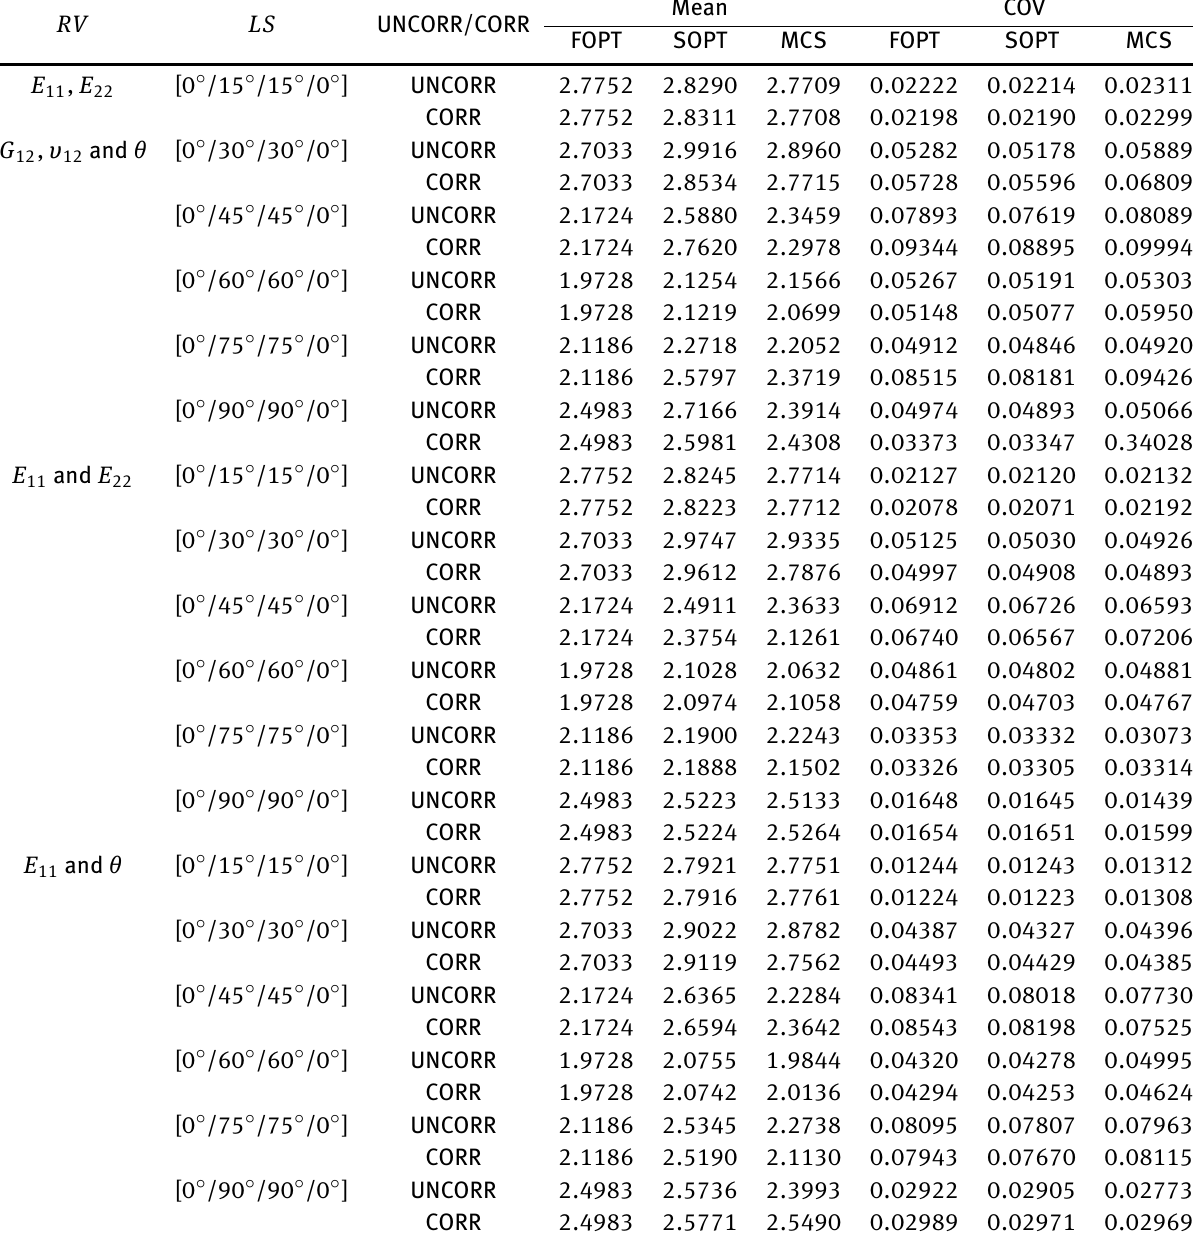
Table 7: Effect of combined uncorrelated (UNCORR) and combined correlated (CORR) random variables on the normalized mean and COV of SIF K I with COC=0.1 and COR=0.5 for different lamination schemes ( LS )